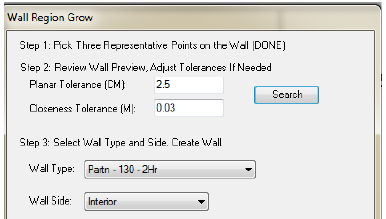
Figure 11. Scan to BIM Wall Creation Settings